Question: Write the caption for this figure.
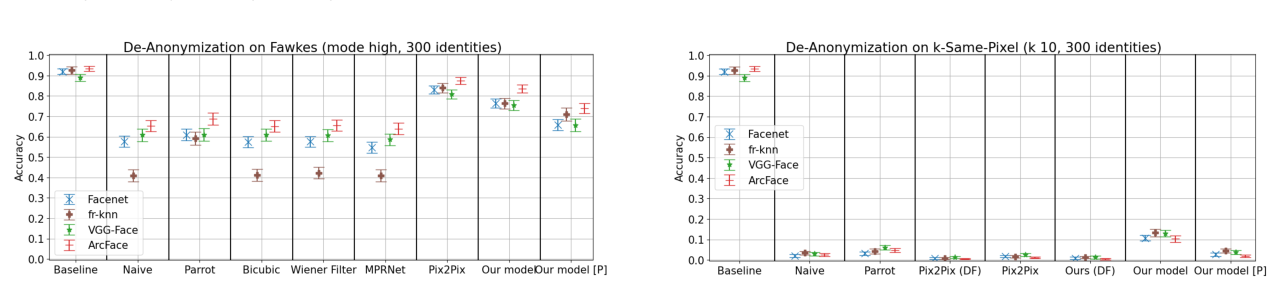
Answer: Recognition accuracy for k-Same-Pixel, given for baseline, naive, parrot, de-anon. via Pix2Pix trained on DigiFace-1M, via Pix2Pix, via our model trained on DigiFace- 1M, via our model; on 300 identities of CelebA.